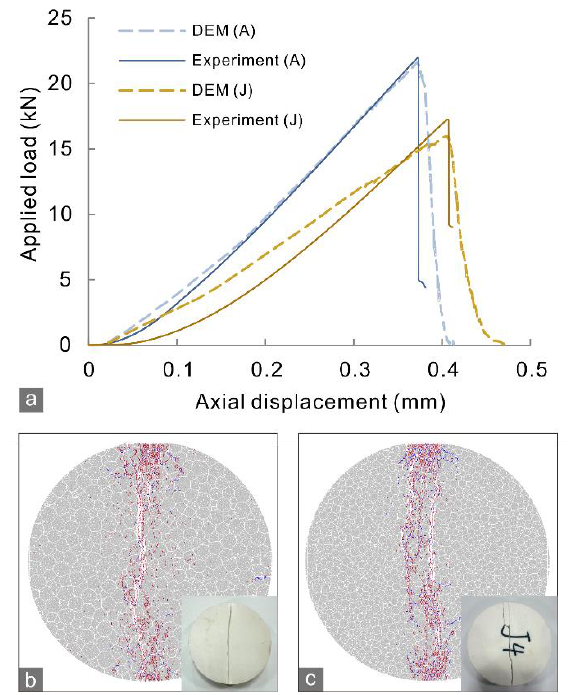
Figure 9. ( a ) Load‒displacement relationship of experimental and numerical results for marble A and J in the BD test. ( b , c ) Crack morphologies of the marble A and J specimens in the numerical simulation of BD test and the corresponding experiment results. Table 2. Calibrated microscale parameters of marble A and J